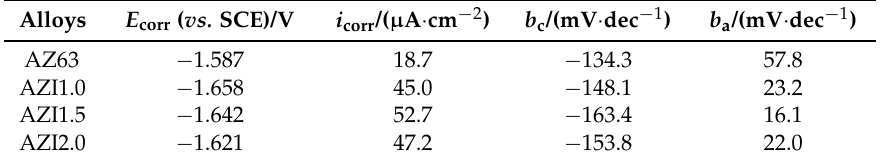
Table 2. Corrosion parameters of AZ63 and AZI alloys derived from the polarization curves. Alloys